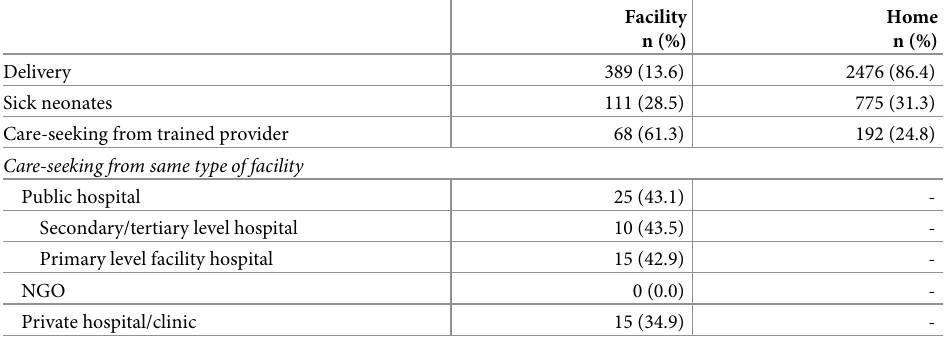
Table 4. Proportion of care-seeking for sick neonates from the same facility where delivery was